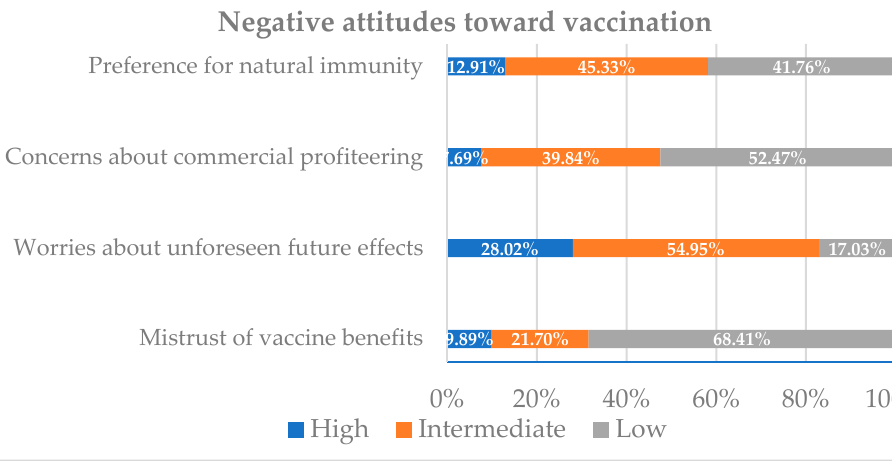
Table 3. Linear regression model of the Mistrust of Vaccine Benefits subscale from the VAX Scale. Mistrust of Vaccine